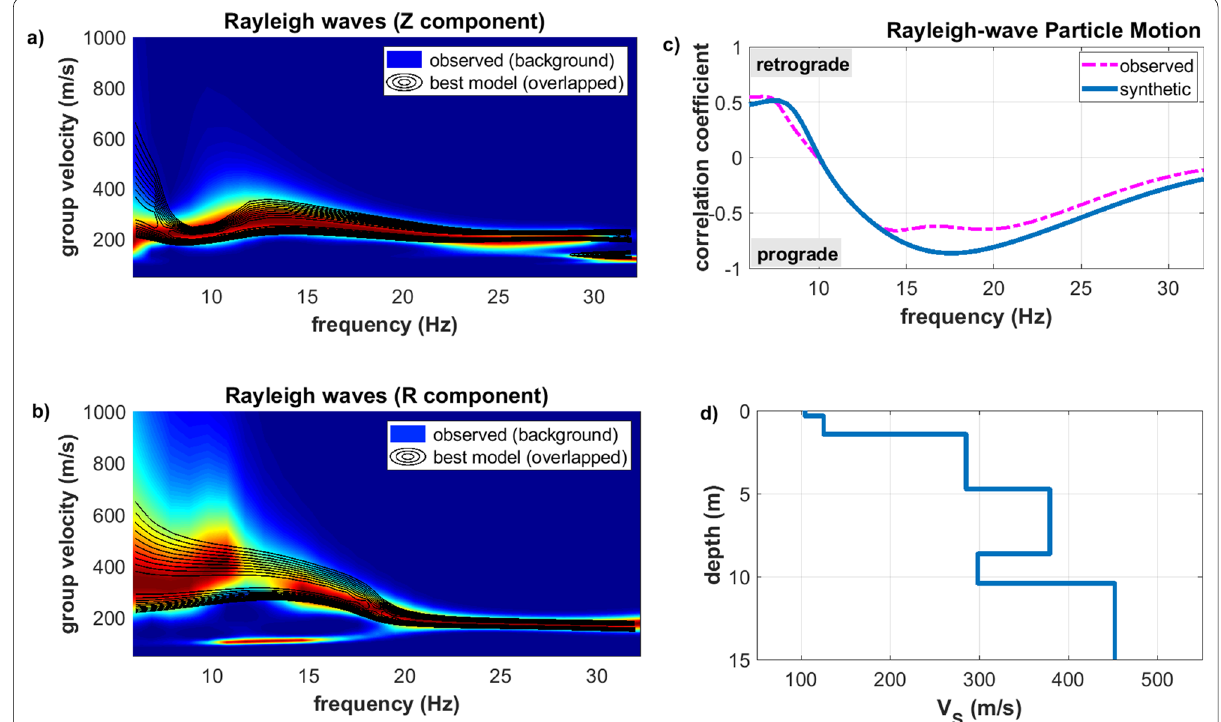
Fig. 7 San Marco area—P2 site. Joint analysis of the HS seismic data: a field (background colours) and synthetic (overlying black contour lines) group-velocity spectra for the vertical (Z) component of Rayleigh waves; b group velocity spectra for the radial (R) component of Rayleigh waves; c field (dashed magenta line) and synthetic (blue line) RPM frequency curves (Rayleigh-wave particle motion appears largely prograde along most of the considered frequency range); d obtained V S profile (minimum-distance model obtained from the multi-objective data